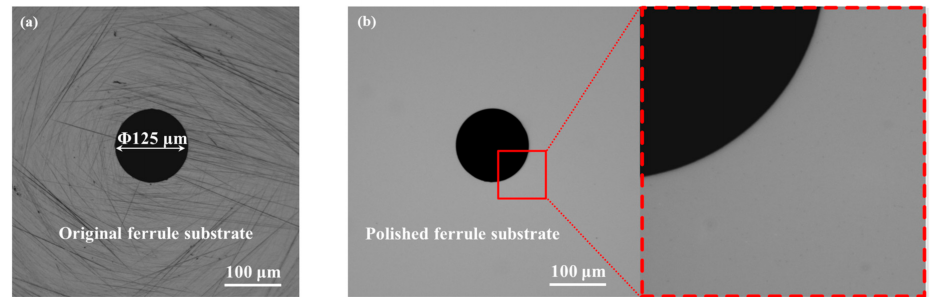
Figure 4. The micrograph of a ferrule endface ( a ) before and ( b ) after polishing (magnification of 100 × ). Inset: The magnification image of the rectangular area (magnification of 600 ×